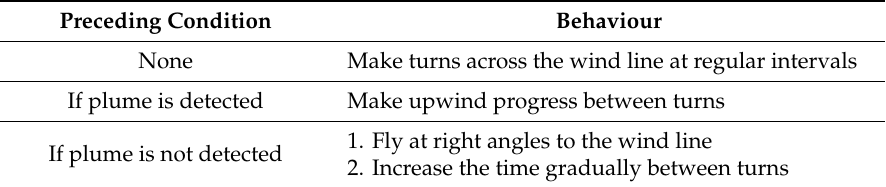
Table 10. A tuned-counterturns strategy proposed by Delanger and Willis [83].